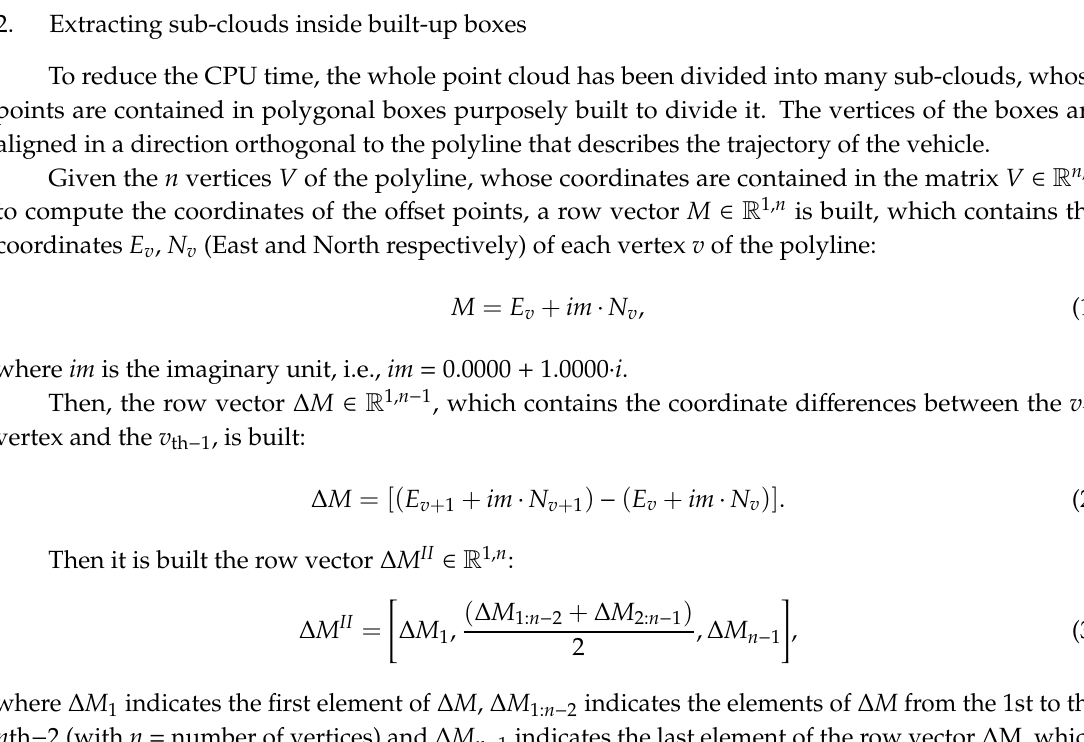
Figure 4. Planimetric scheme of the vehicle’s trajectory extraction. ( a ) Excerpt of the cloud of points having a scanning angle ranging from −5 to 5 degrees, the chromatic scale is related to the angular variation. ( b ) Excerpt where only points with zero scanning angle are highlighted (in green). ( c ) Selected points with zero scanning angle, the arrow shows the increasing GPS time values. ( d ) Identification of vertex V 2 starting from vertex V 1 which is the one with the lowest GPS time value.